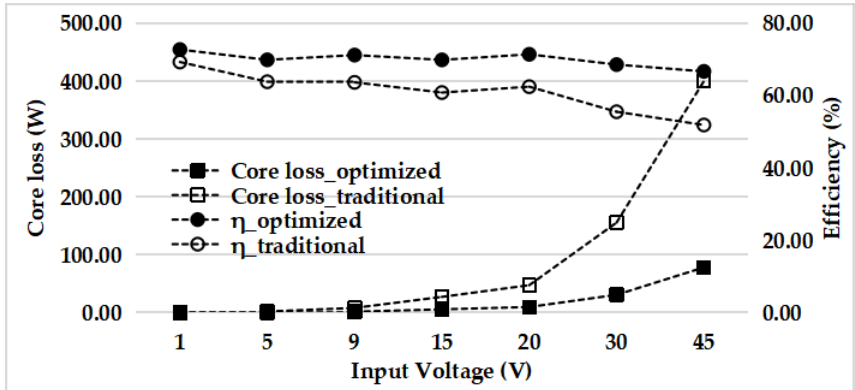
Figure 16. Core loss and efficiency in voltage scales with optimized rectangular core.